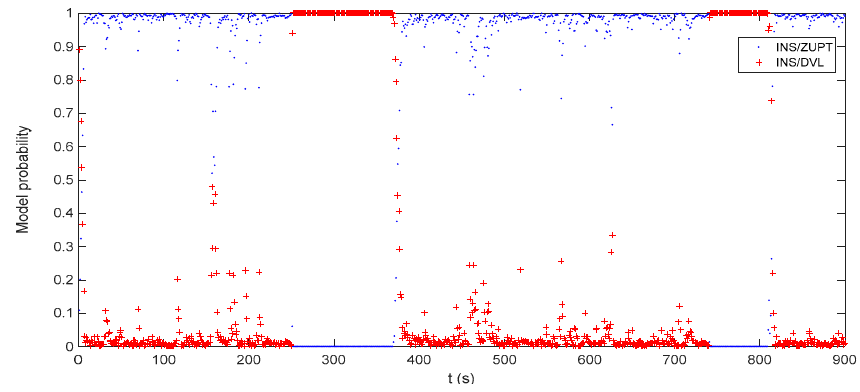
Figure 12. Model probability of the IMM-aided ZUPT solution.